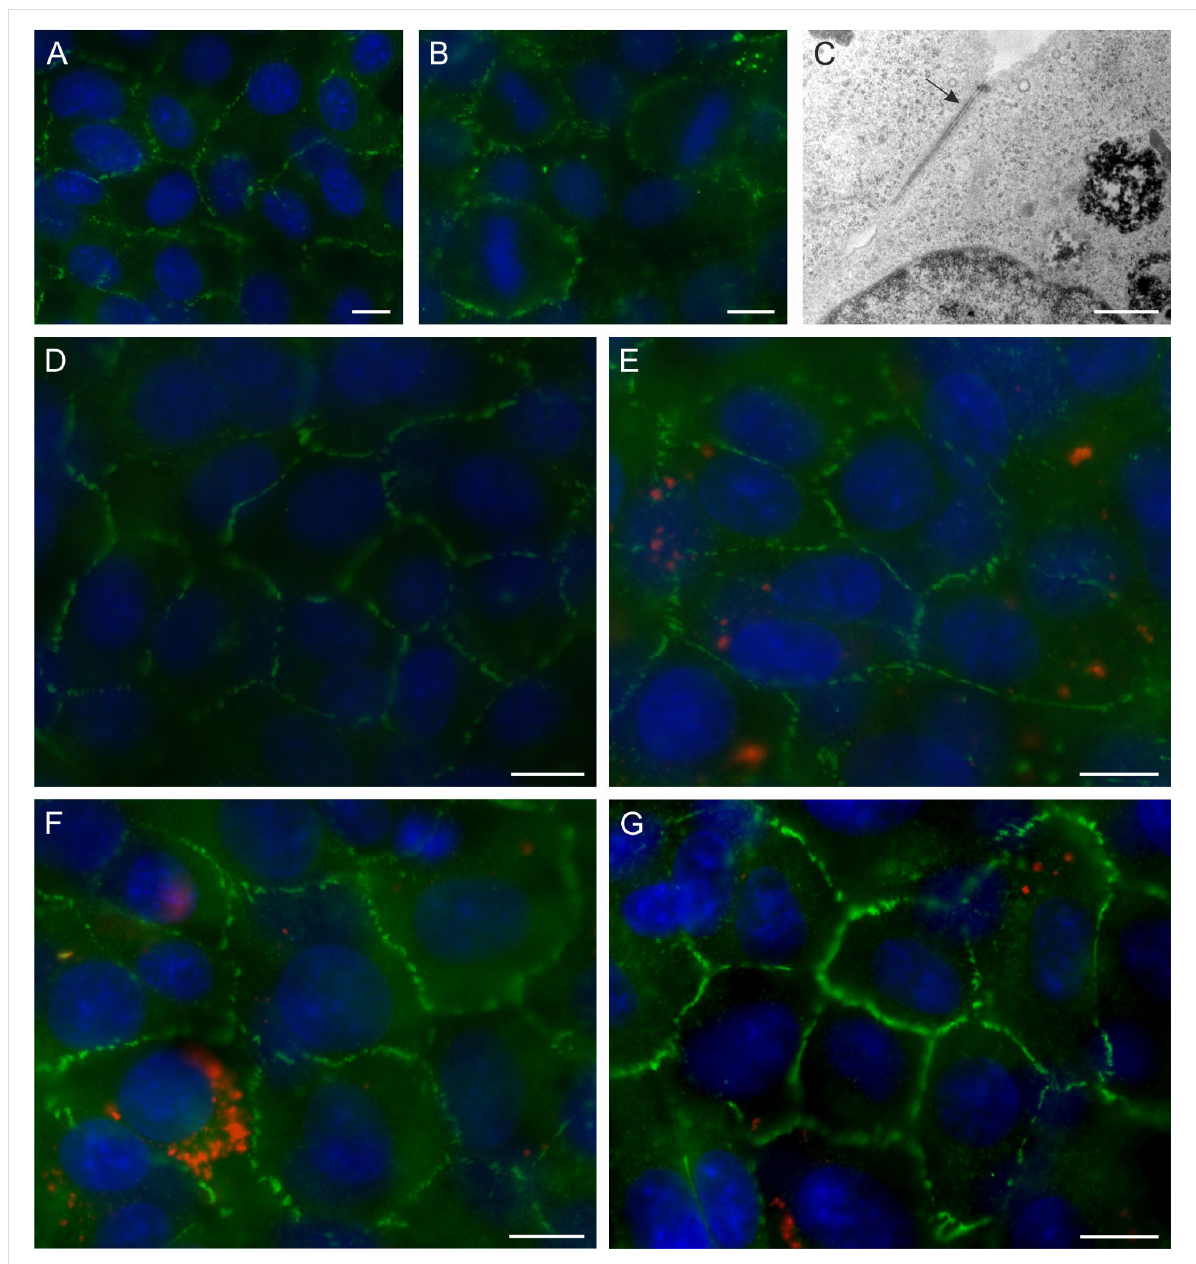
Figure 5: Representative microscopic images of rBCEC4 cells stained for TJs. Staining (green) shows expression of ZO-1 (A, D-G) and occludin (B) in rBCEC4 cells. TEM further confirmed existence of TJs in these cells (C). PLLA-NPs were used to investigate possible effects of NP exposure on rBCEC4 cells: control (D), PLLA-NPs were added shortly after seeding the cells (E), about 24 h before cells reached full confluence (F) and after monolayer formation (G). No difference between control and any of the three conditions of NP exposure could be detected. PLLA-NPs are shown in red. Cell nuclei were counterstained with Hoechst (blue). Concentration of PLLA-NPs was [24.9 µg/mL]. Scale bars: 10 µm (A, B, D–G). Scale bar 1 µm (C).